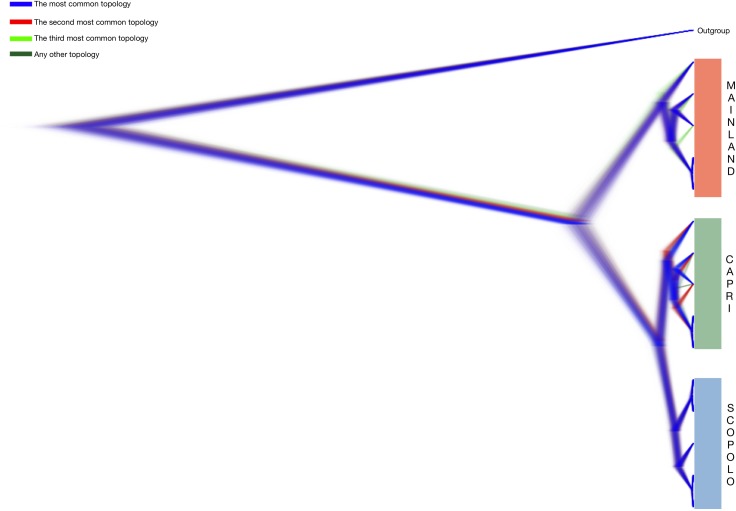
Population tree inferred with *BEAST visualized using DensiTree [40].All trees created in the analysis (except the burn-in phase) are displayed. Trees with the most common topology are highlighted in blue, trees with the second most common topology in red, trees with the third most common topology in pale green and all other trees in dark green. On the right, colours of subclades indicate populations from mainland (orange), Capri (green) and Scopolo (azure).